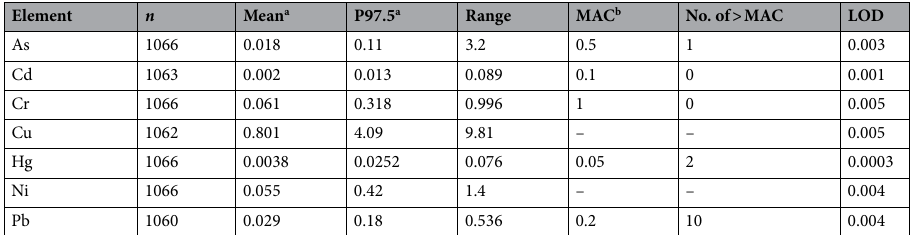
Table 2. The concentration of heavy metals in meat samples from Zhejiang province (mg/kg fresh weight). a Target analytes with concentrations lower than LOD were treated as one-half of LOD when calculating the mean values. b Maximum allowable concentrations of contaminants in